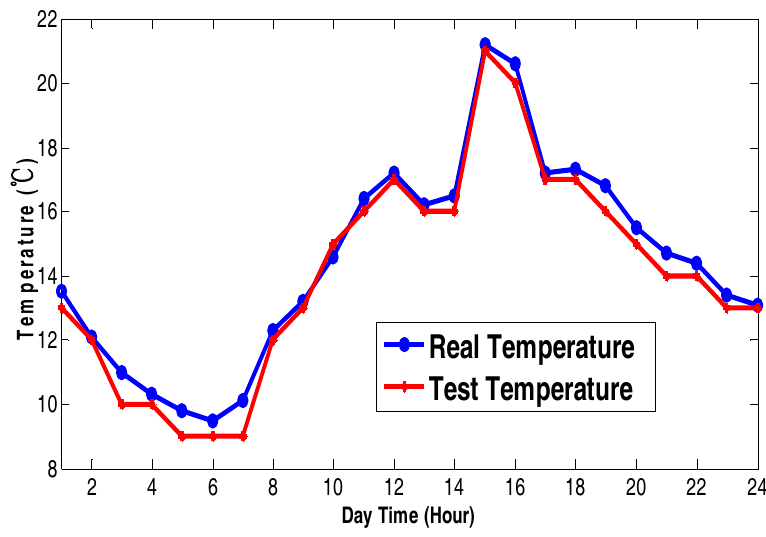
Figure 26. Real-time temperature changes on a cloudy day.